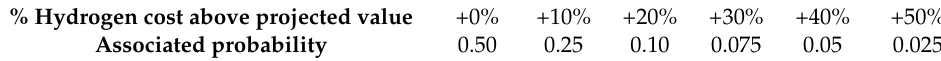
Table 2. Uncertainty of forecast hydrogen cost.